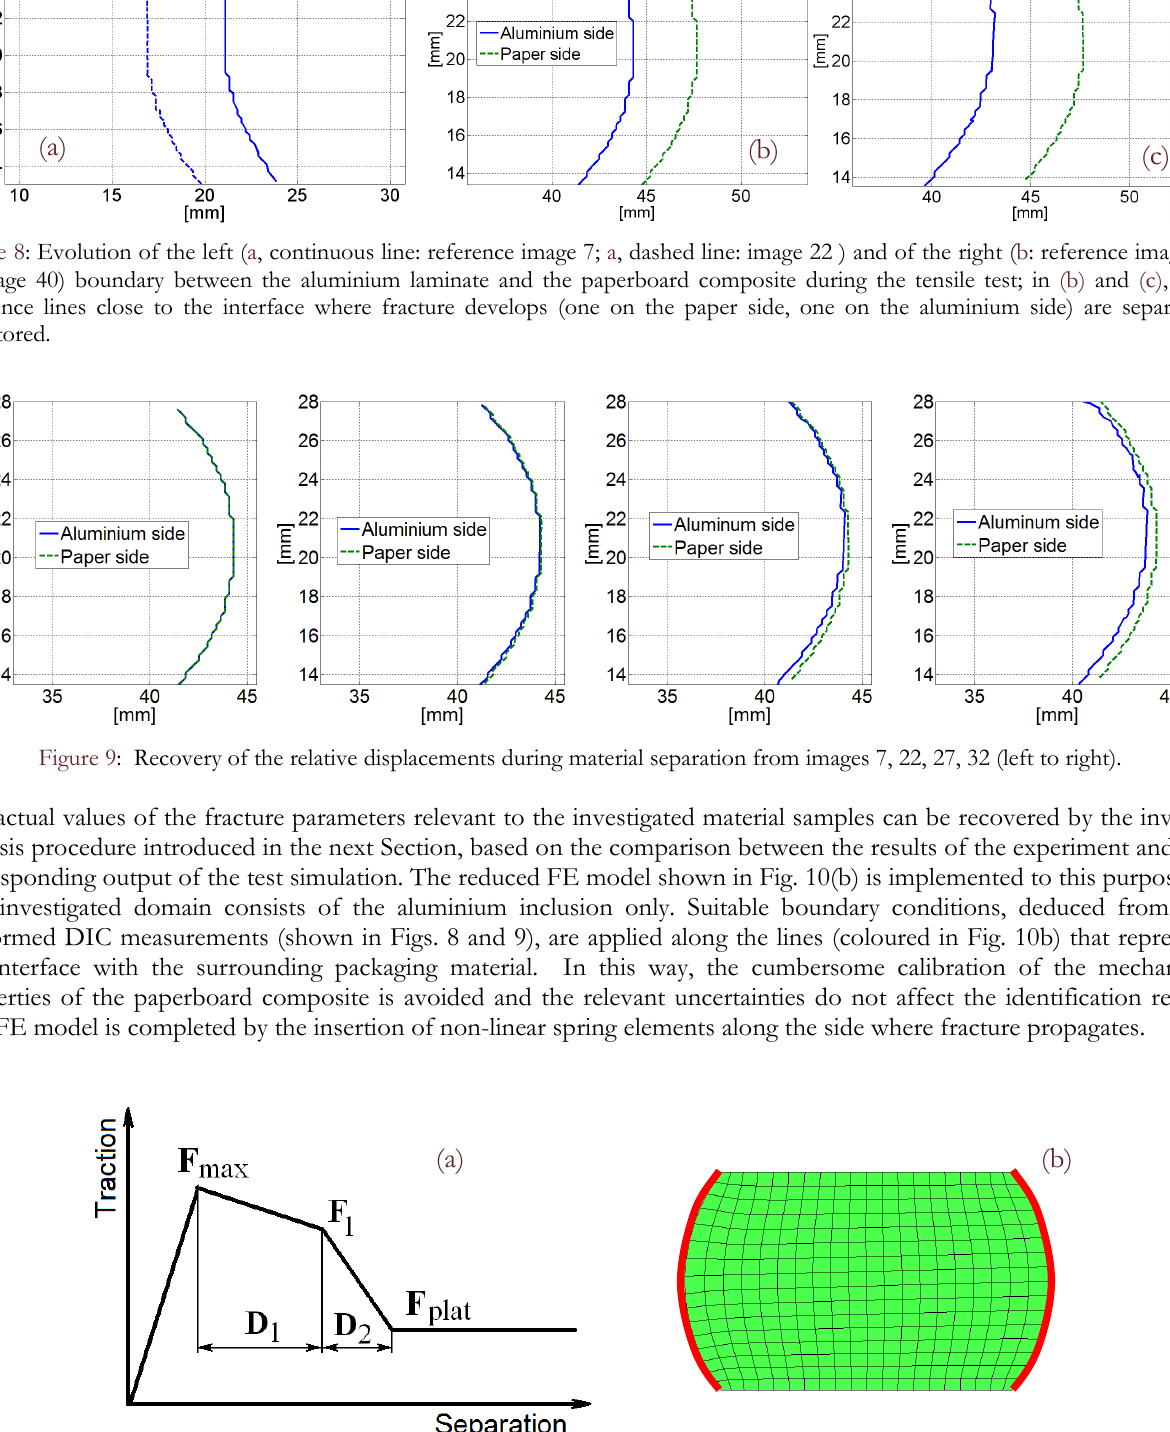
Figure 10: Schematic representation of the assumed traction − separation law and the reduced FE model exploited for identification